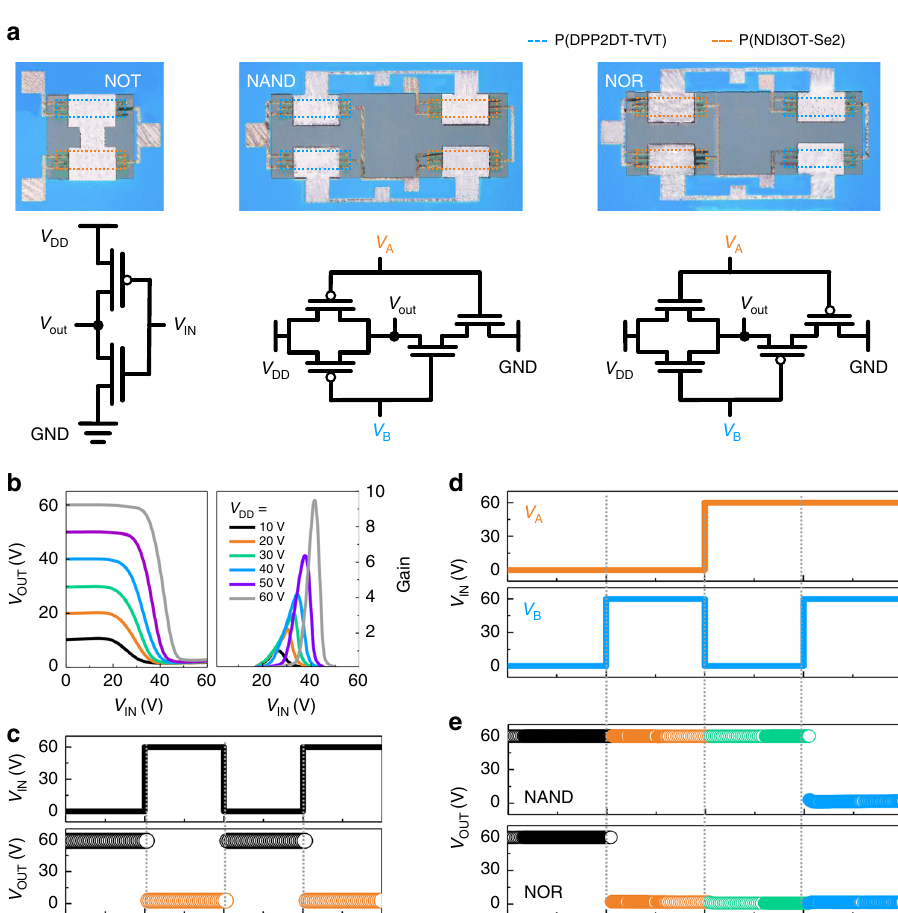
Fig. 5 Electrical characteristics of all-photopatterned logic circuits. a OM images and schematic circuit diagrams of NOT, NAND, and NOR logic gates based on all-photopatterned p -type P(DPP2DT-TVT) and n -type P(NDI3OT-Se2) PTFTs. b Voltage transfer curves and signal inverter gain of NOT gate. c Response characteristics of NOT gate. d Four possible logic combinations: (0, 0), (1, 0), (0, 1), and (1, 1). e Output voltages of NAND and NOR gates for the four logic combinations in d